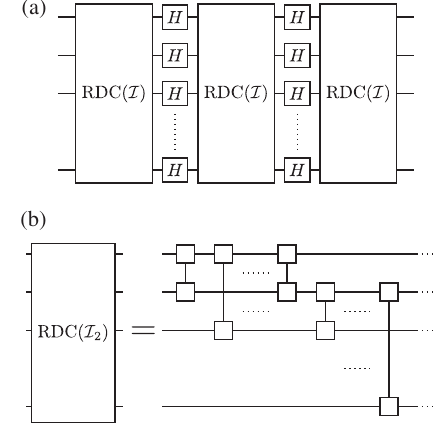
FIG. 2. Panel (a) depicts iterations of RDC ð I Þ andthe Hadamard transformation.Panel(b)showsRDC ð I 2 Þ , where randomdiagonal two-qubit gates are applied onto all pairs. The circuit is called RDC ð t Þ ð I 2 Þ when each two-qubit gate is replaced with disc ð diag Z f 1 ; e i φ 1 g ⊗ diag Z f 1 ; e i φ 2 gÞ diag Z f 1 ; 1 ; 1 ; e i ϑ g , where the phases ϕ 1 , ϕ 2 and ϑ are chosen from discrete sets given in the main text.